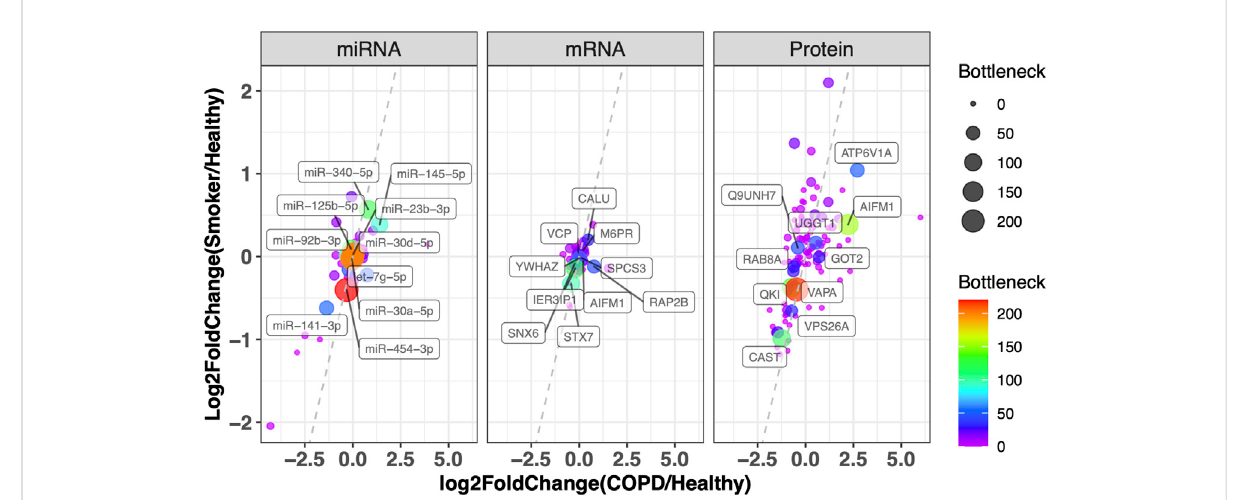
FIGURE 4 Prioritizationofdiseasegenesbytopological characterinthenetwork andDEGinCOPD.PlotofmiRNA,mRNA,andproteinwiththeirlog2fold change in COPD vs. healthy ( x -axis) and smoker vs. healthy ( y -axis). The color and node size correspond to their bottleneck values in the Integrative Network. The symbols of the top 10 miRNAs, mRNAs, and proteins with the highest bottleneck values are labeled (the full node characters in the network and differentially expressed tests are provided in Supplementary Table S2). VCP: valosin-containing protein; YWHAZ: tyrosine 3- monooxygenase/tryptophan 5-monooxygenase activation protein, zeta; CALU: calumenin; SNX6: sorting nexin 6; M6PR: mannose-6-phosphate receptor, cation-dependent; IER3IP1: immediate early response 3-interacting protein 1; SPCS3: signal peptidase complex subunit 3; RAP2B: RAP2B, member of the RAS oncogene family; STX7: syntaxin 7; AIFM1: apoptosis-inducing factor mitochondria-associated 1; ATP6V1A: ATPase H+- transporting V1 subunit A; Q9UNH7: sorting nexin 6; UGGT1: UDP-glucose:glycoprotein glucosyltransferase 1; RAB8A: Ras-related protein Rab-8A; GOT2: glutamic oxaloacetic transaminase 2; QKI: quaking; VAPA: virulence-associated protein A; VPS26A: vacuolar protein sorting-associated protein 26a; CAST: